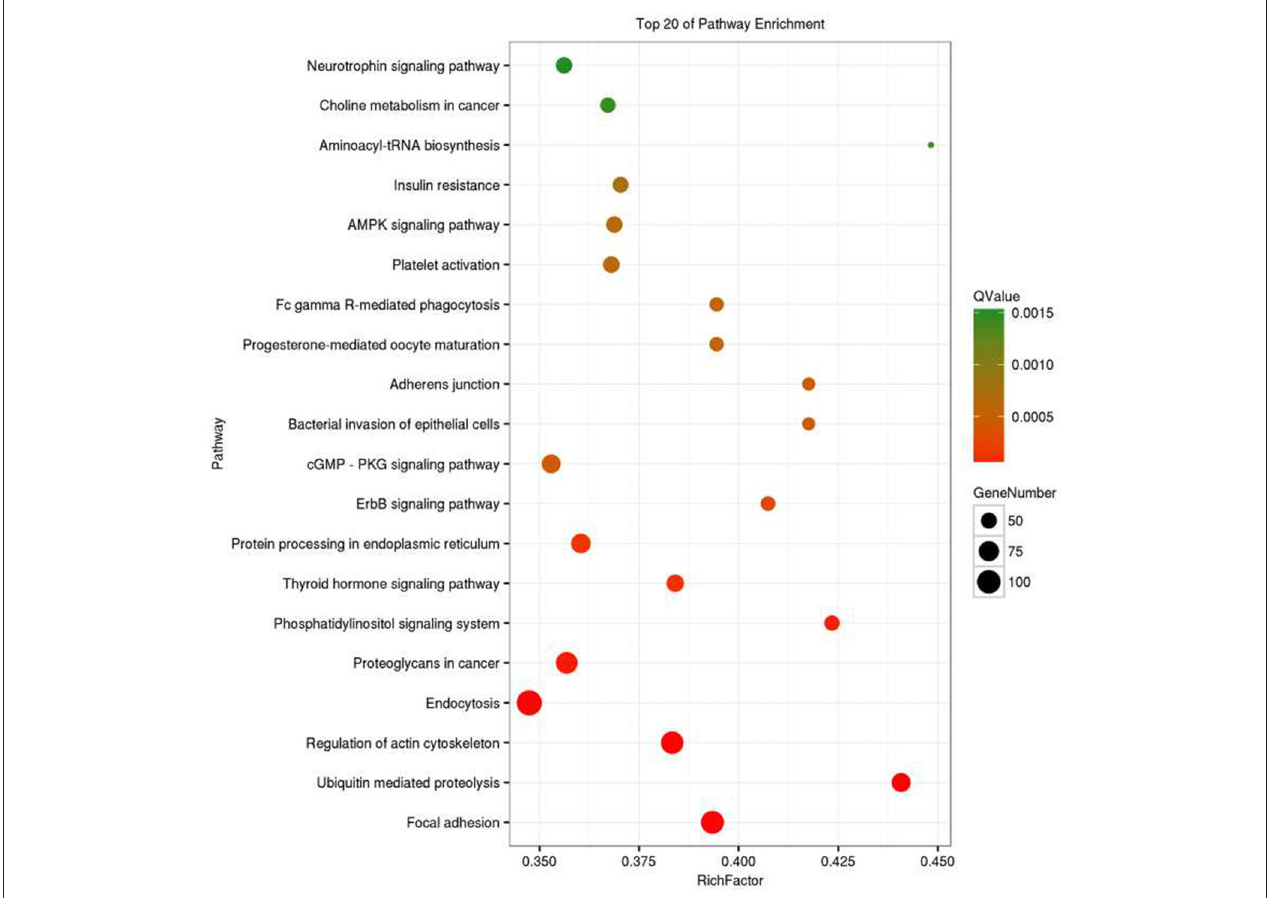
FIGURE 8 | Top 20 of pathway enrichment analysis for circRNAs gene